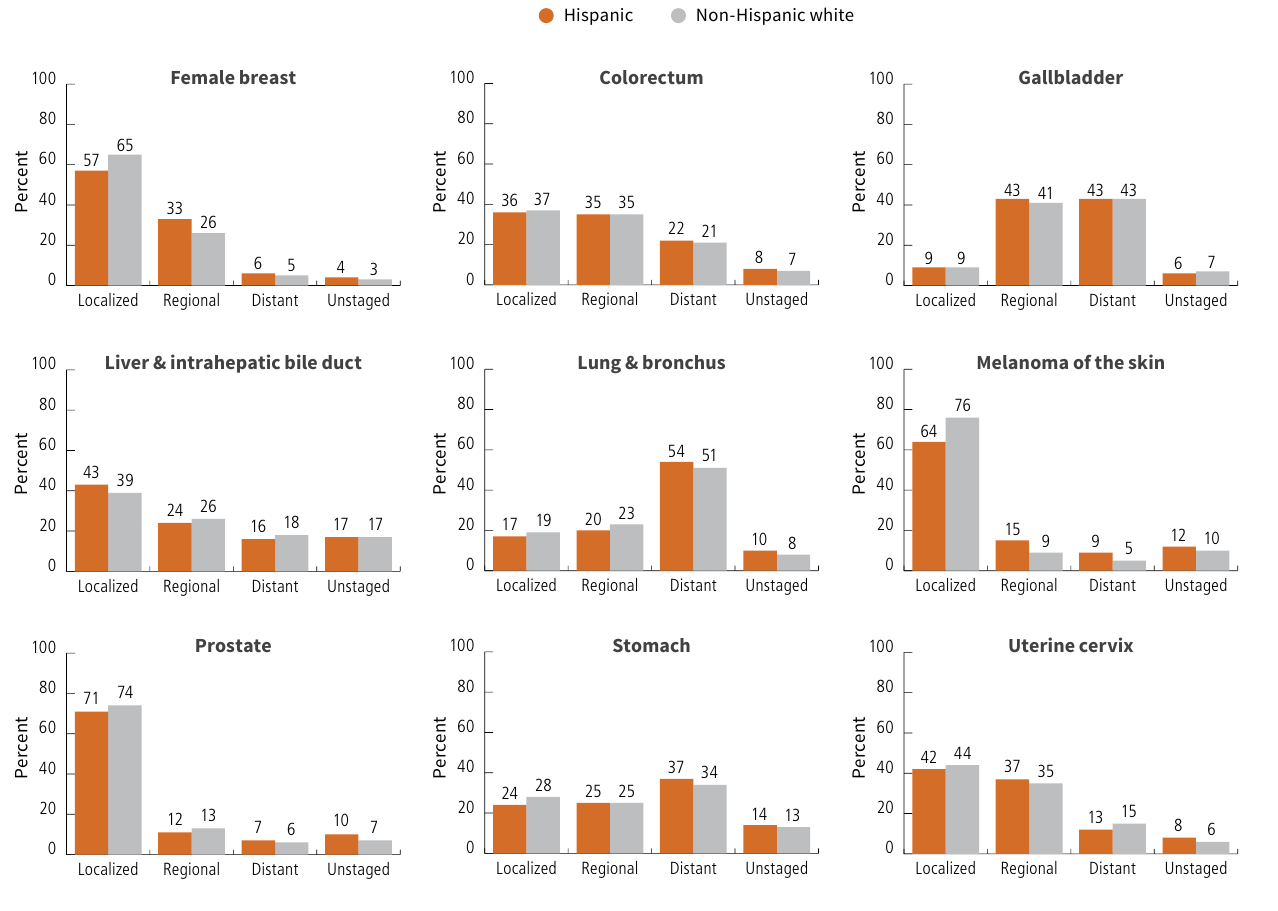
Figure 5. Stage Distribution for Selected Cancers in Hispanics and Non-Hispanic Whites, US, 2011-2015